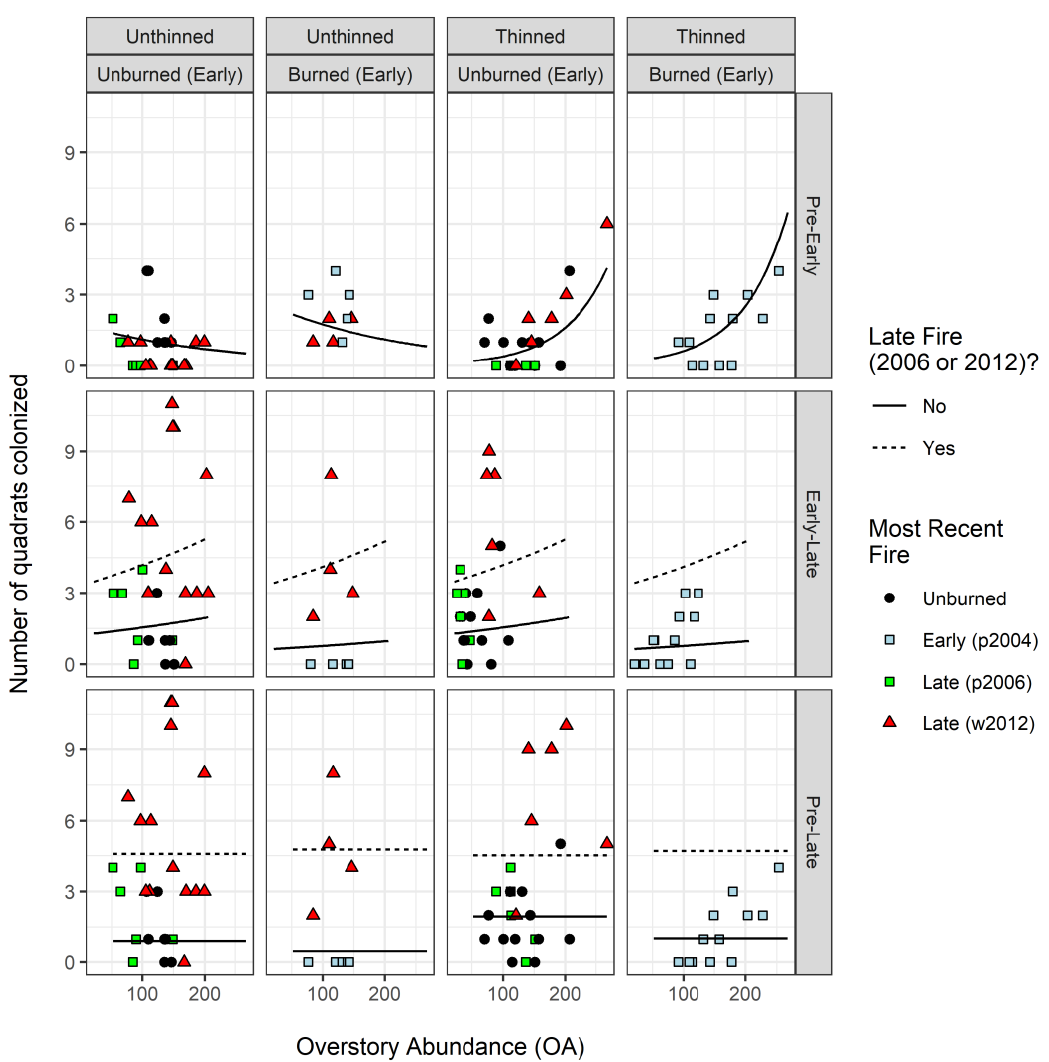
Figure 6. Colonization of seedlings ( < 1 m tall) expressed as the number of quadrats per plot into which seedlings recruited during a sampling interval. Rows distinguish Pre–Early, Early–Late, and Pre–Late intervals. For each interval, plot values of OA represent the start of the interval. See Figure 3 for other details and Table 2 for statistical